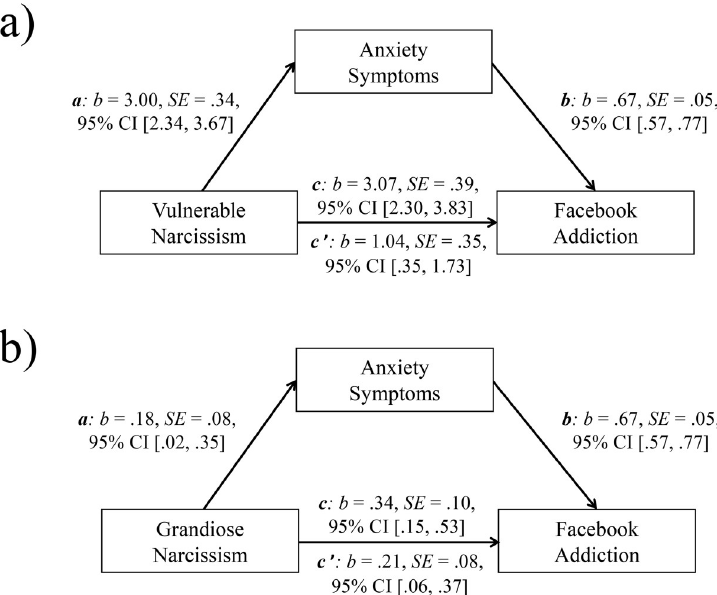
Fig 1. a. Mediation model including vulnerable narcissism (predictor), anxiety symptoms (mediator), and Facebook Addiction (outcome). b. Mediation model including grandiose narcissism (predictor), anxiety symptoms (mediator), and Facebook Addiction (outcome). (c = total effect, c’ = direct effect; b = standardized regression coefficient, SE = standard error, CI = confidence